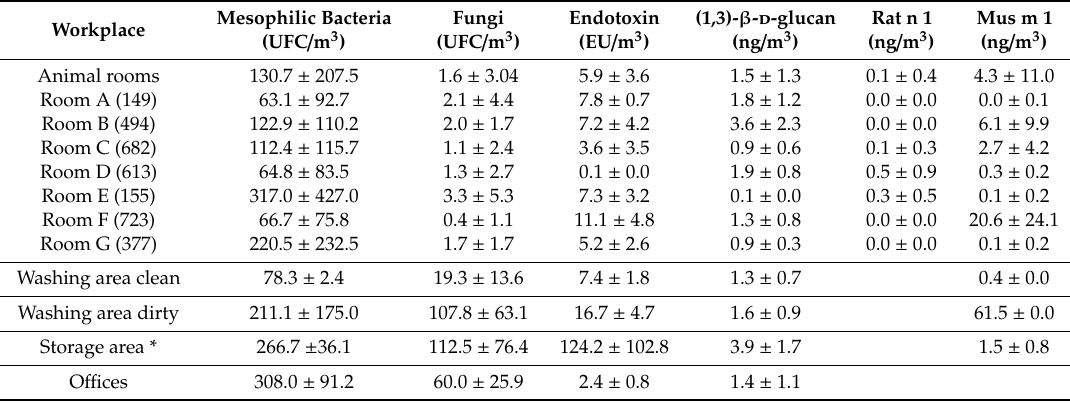
Table 3. Concentrations (mean value and standard deviation) of mesophilic bacteria, fungi,